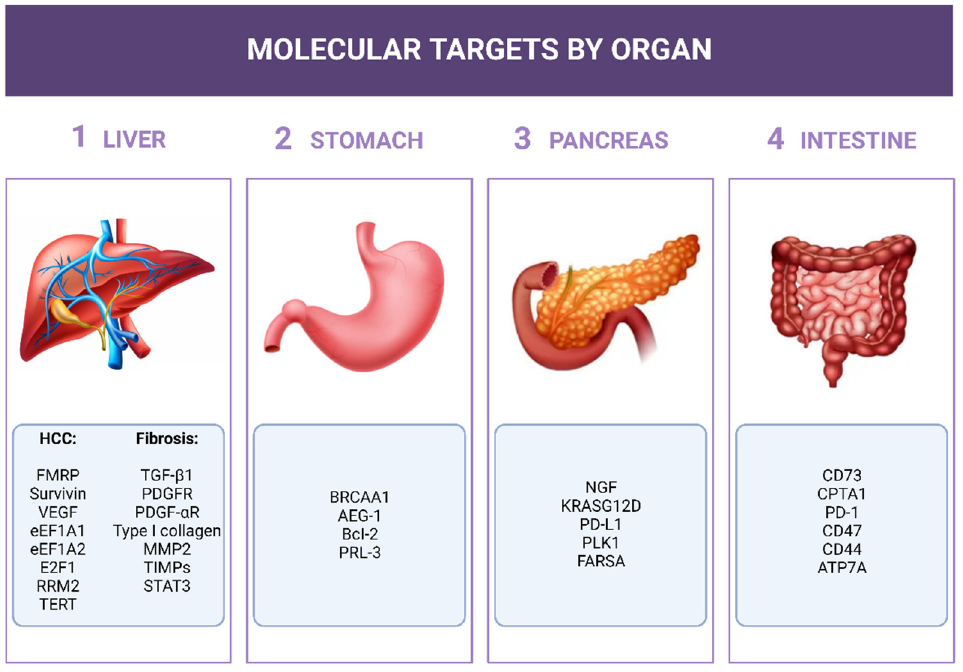
Figure 3. siRNA molecular targets for siRNAs. The mRNAs considered as targets for the siRNA described in the text have been listed close to the respective organ.